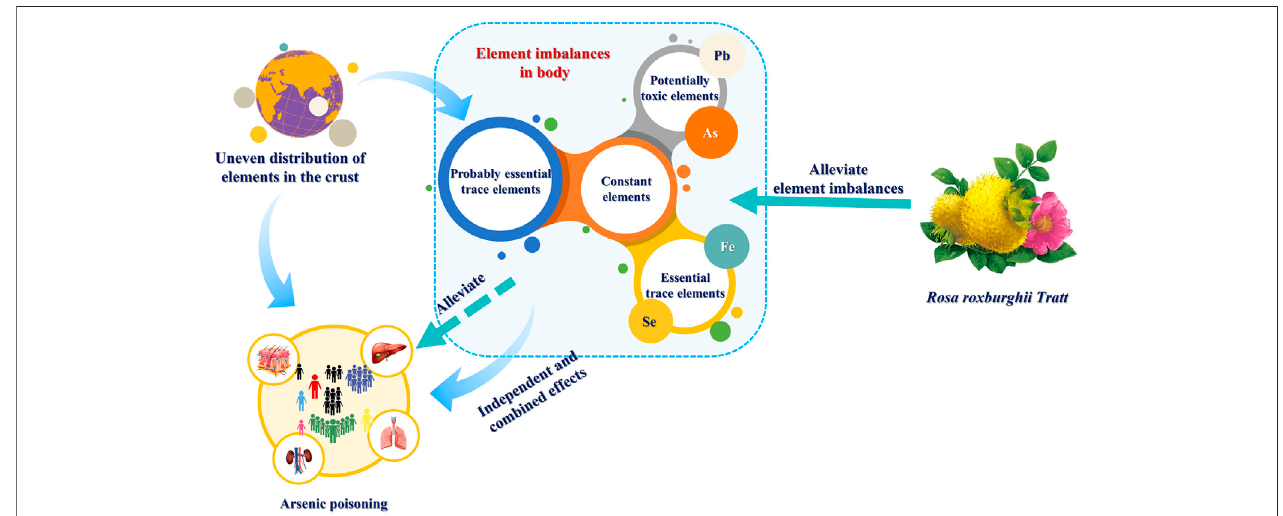
FIGURE 6 | Association of element imbalances with arsenism and the potential application value of RRT .